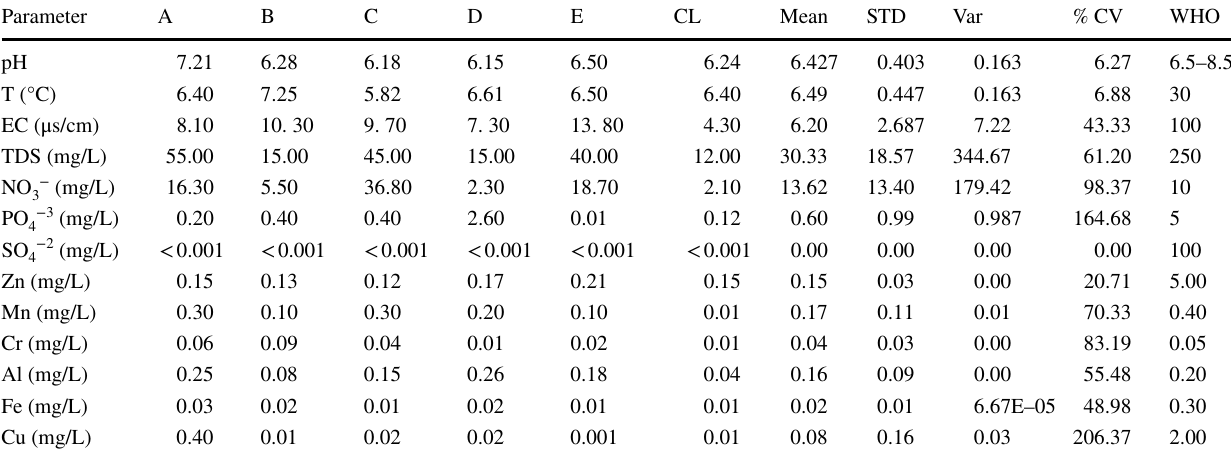
Table 2 Physicochemical properties of the groundwater samples